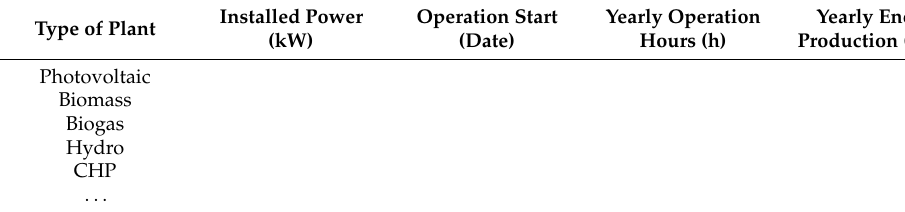
Table A4. Data requested for public renewable energy plants.